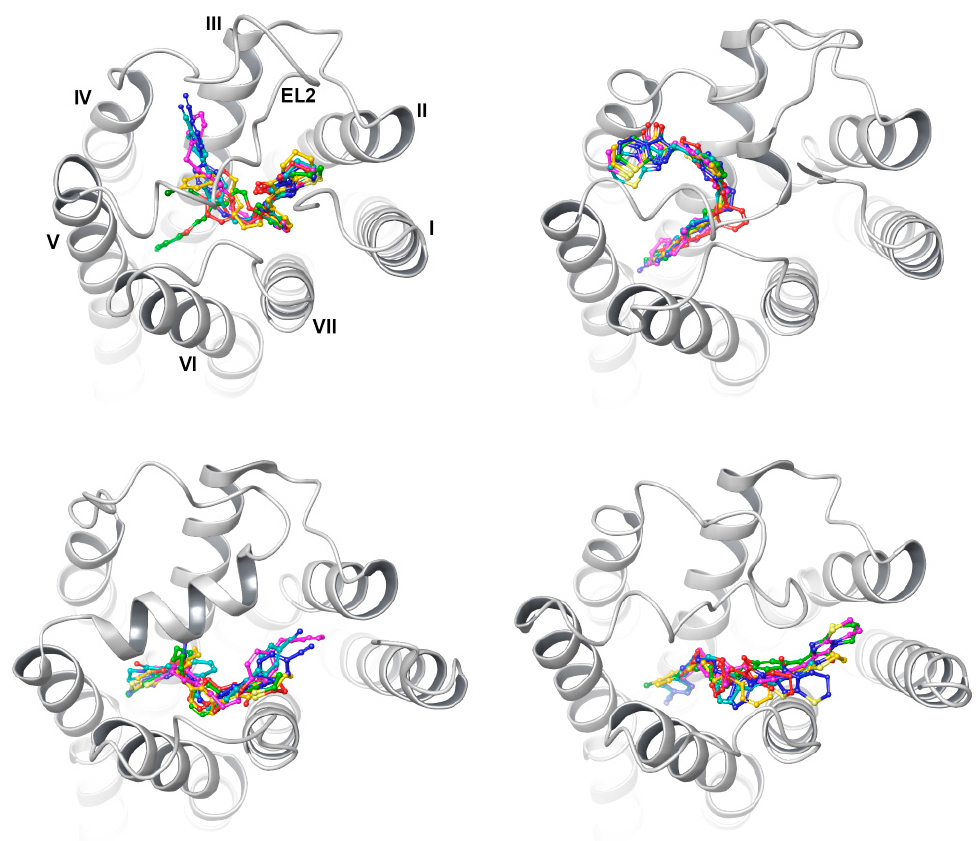
Figure 8. Top view of putative binding poses of the docked ligand set to TTA ( top left ), AF-DM ( top right ), PF-DM ( bottom left ), and CF-DM ( bottom right ) models. Roman numerals indicate TMs—only marked in IT model for clarity purposes. For a colored figure, please refer to the online version of this paper.